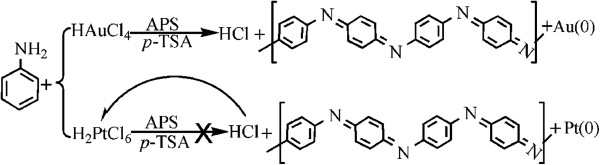
Schematic of a possible mechanism for the formation of hybrid materials of PANI(HAuCl4·4H2O) and PANI(H2PtCl6·6H2O).